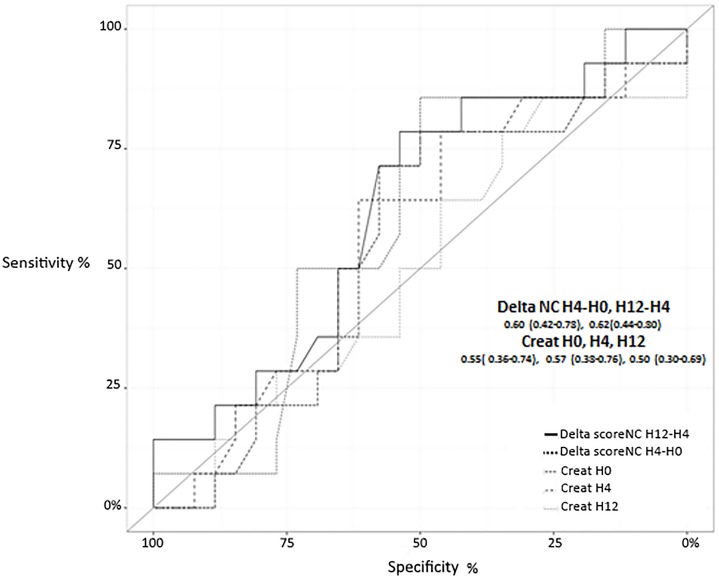
Area under the curves for creatininemia (H0, H4,H12) and for Deltas AKIRisk/NephroCheck score H4-H0 and H12-H4 to differentiate between transient or persistent acute kidney injury.AKI: acute kidney injury; NC: NephroCheck.